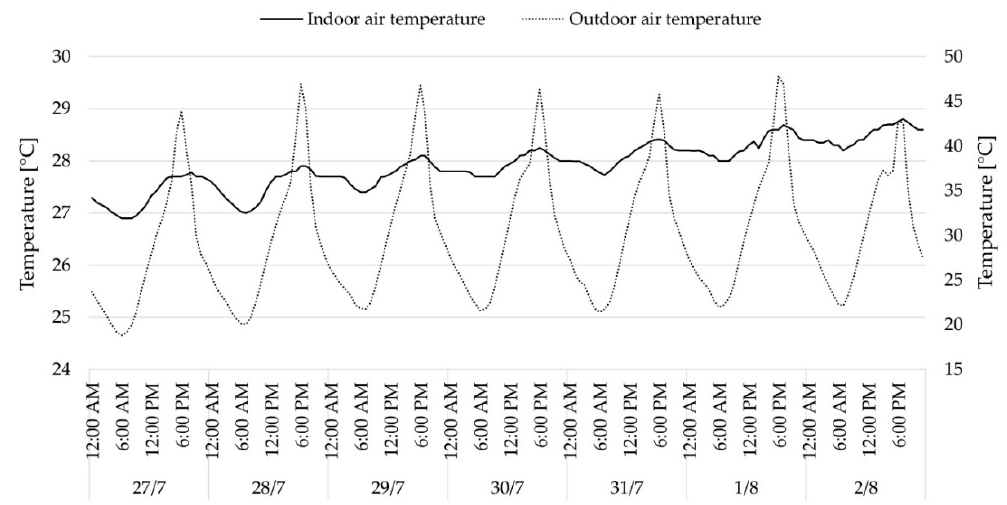
Figure 12. Monitored indoor air temperature vs. outdoor air temperature for the hottest week in summer.